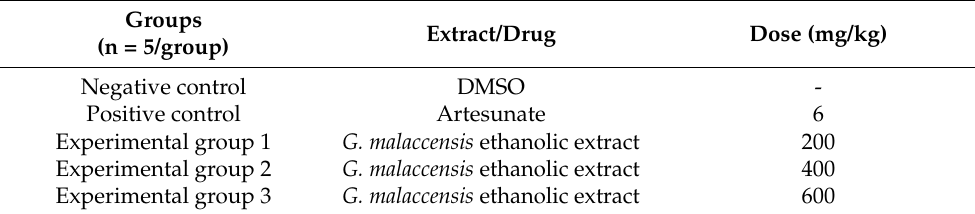
Table 2. Group classifications and doses used in the 4-day suppressive test.